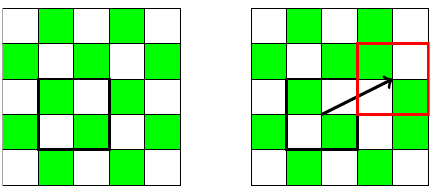
Figure 12. Tamper of green channel pattern by a copy-move modification. The area inside the black square is copied and moved, breaking the CFA pattern within the red